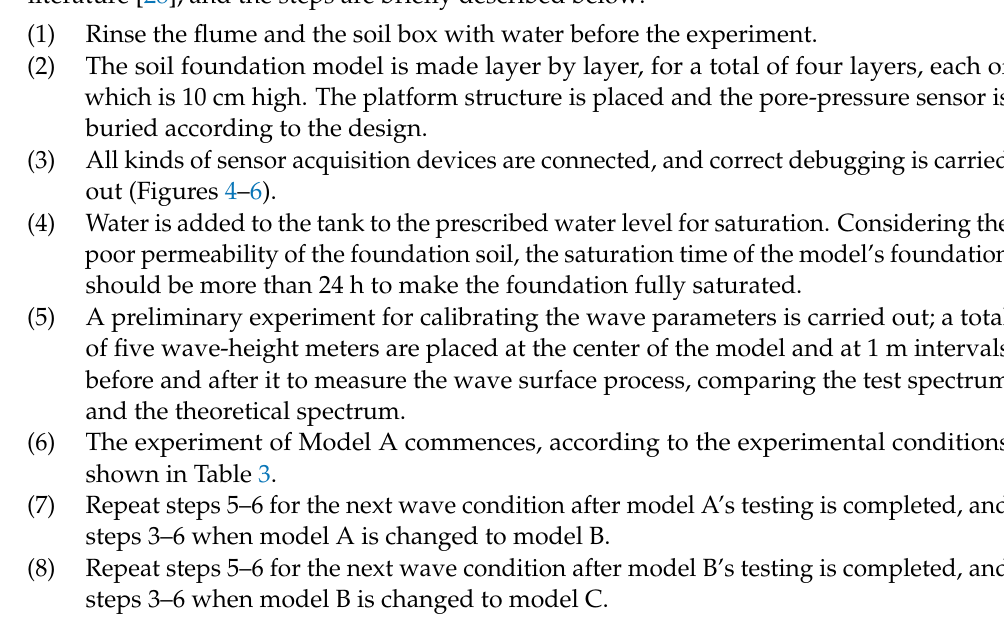
Table 3. Summary of experimental tests for wave, celerity, and platform